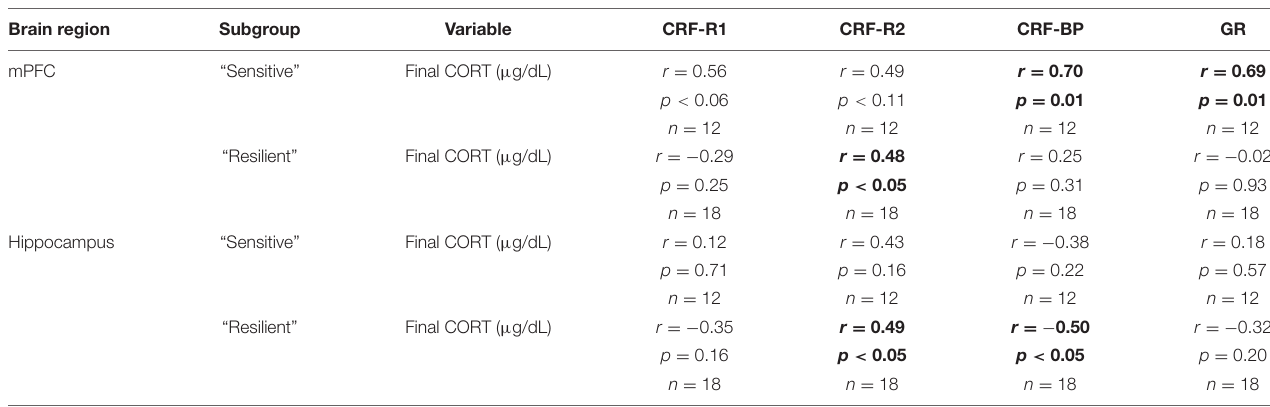
TABLE 3 | Correlations between stress-related proteins and final plasma corticosterone